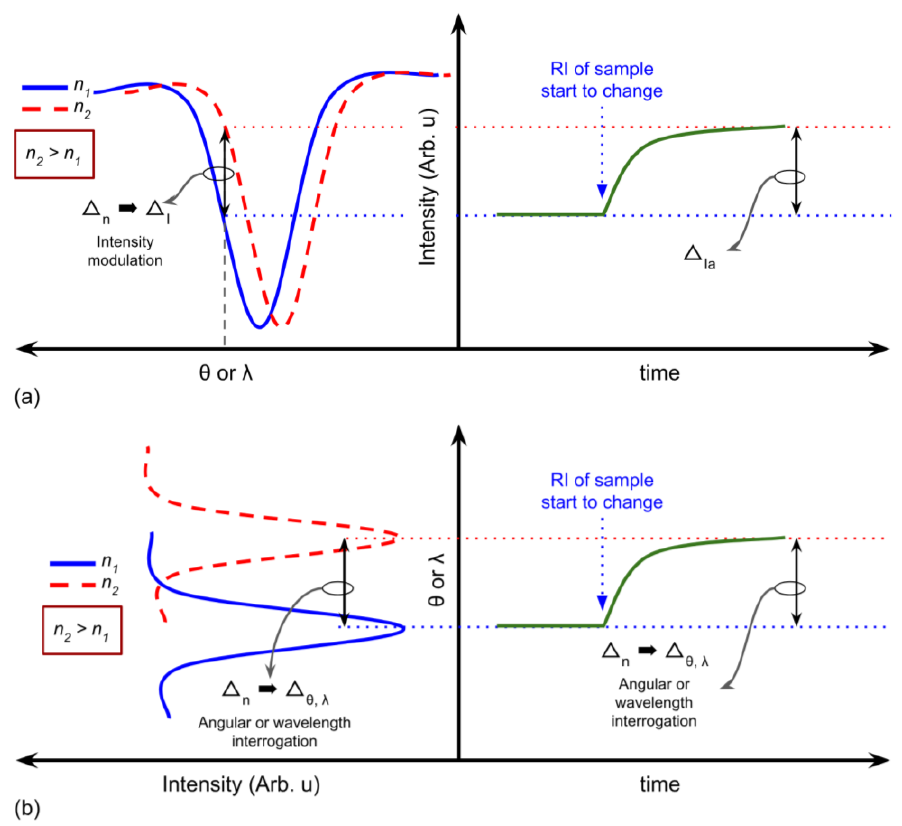
Figure 9. Sensogram curve plot from the SPR measurement methodology by ( a ) intensity modulation and ( b ) angular or wavelength interrogation.